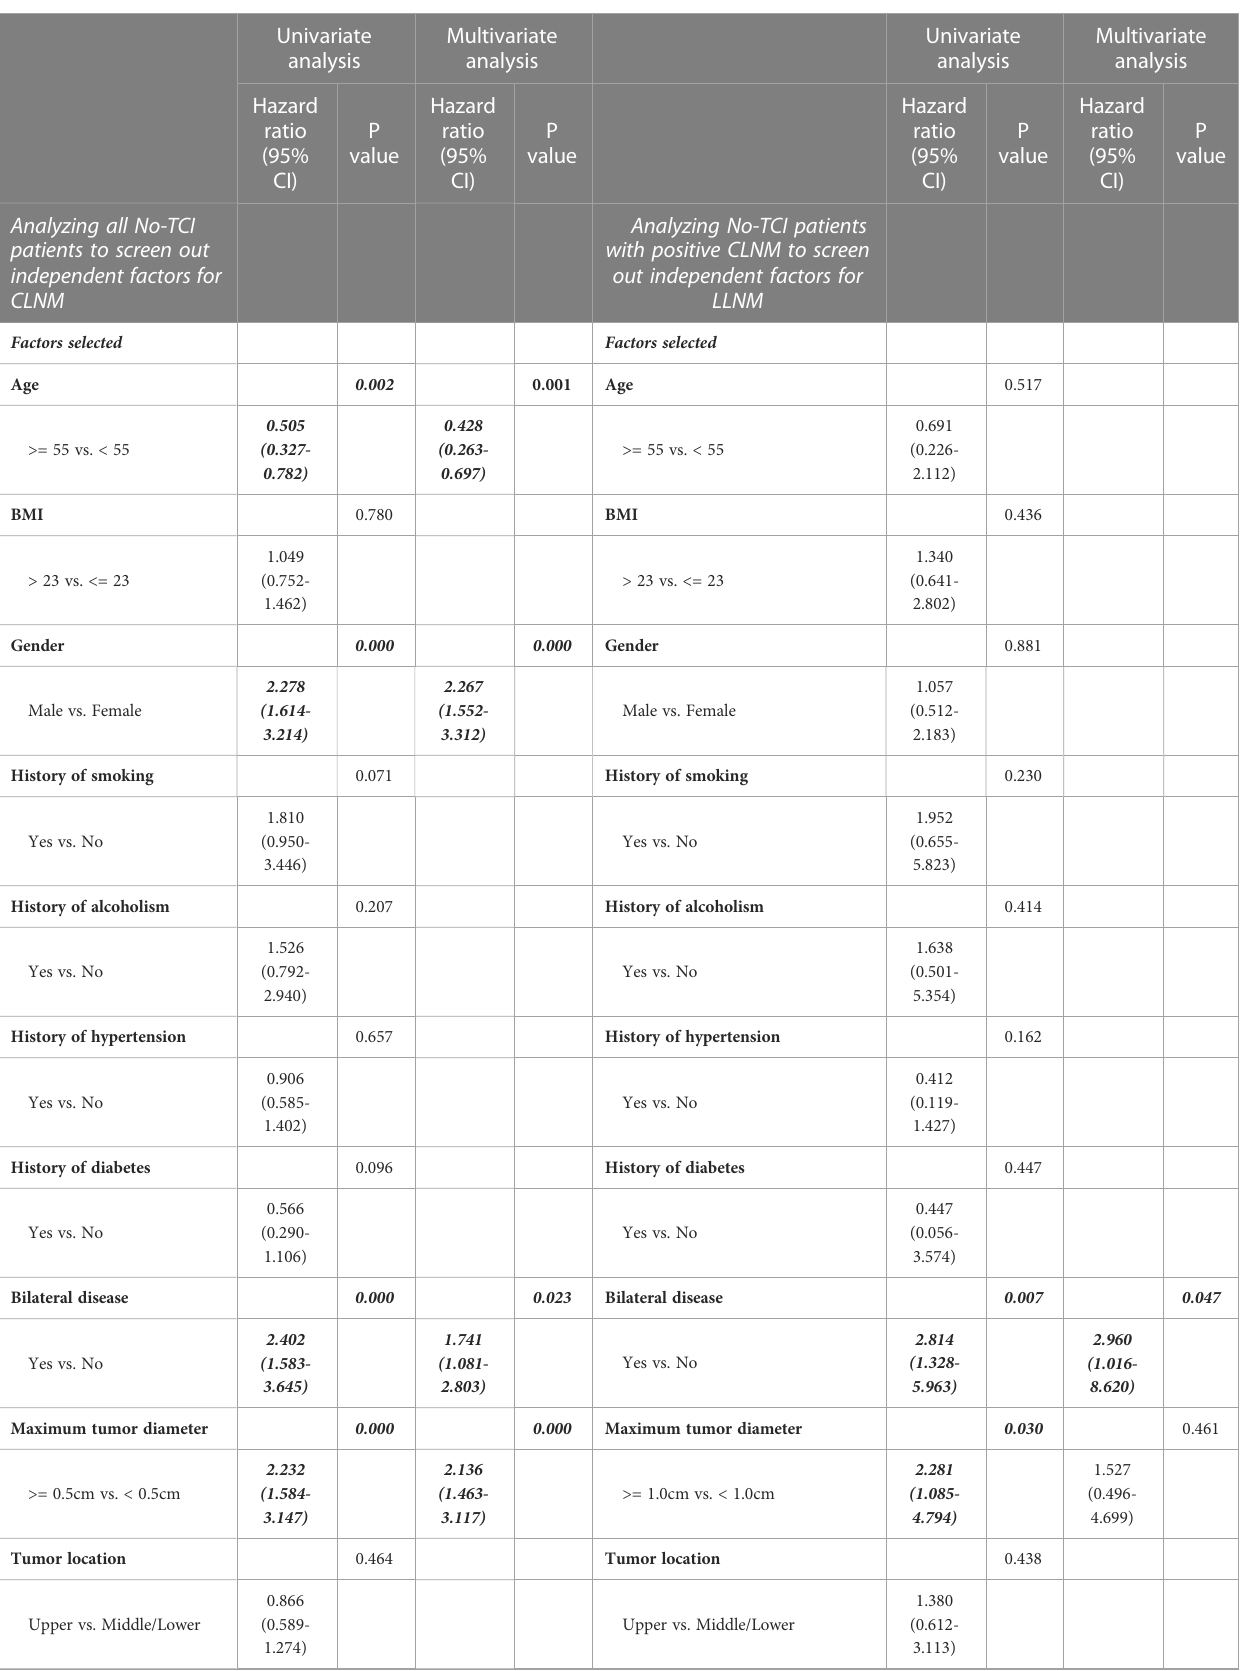
TABLE 2 Univariate and multivariate analyses for PTC patients with negative